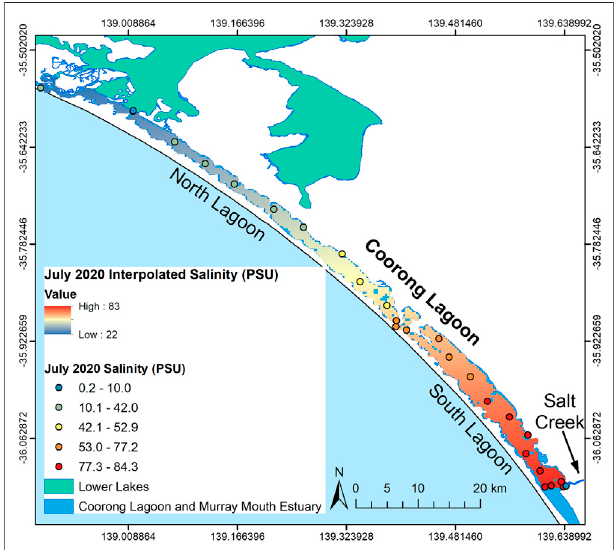
FIGURE 2 | Winter July 2020 salinity measurements and interpolated surface (linear trend in